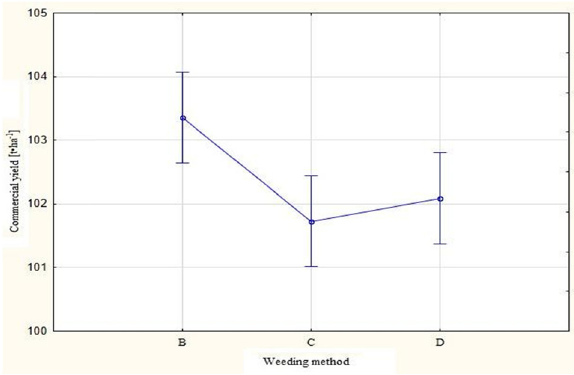
Figure 13: The expected marginal averages for 0.95 con fi dence intervals for commercial yield according to the various methods of weeding carrots in 2018 ( source: own work